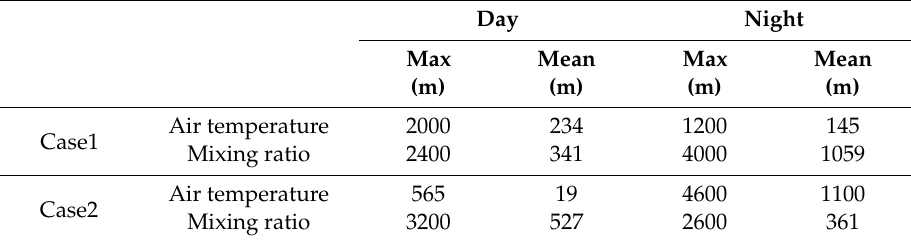
Table 2. Summary of the maximum and mean distances of the a ff ected area from the river.